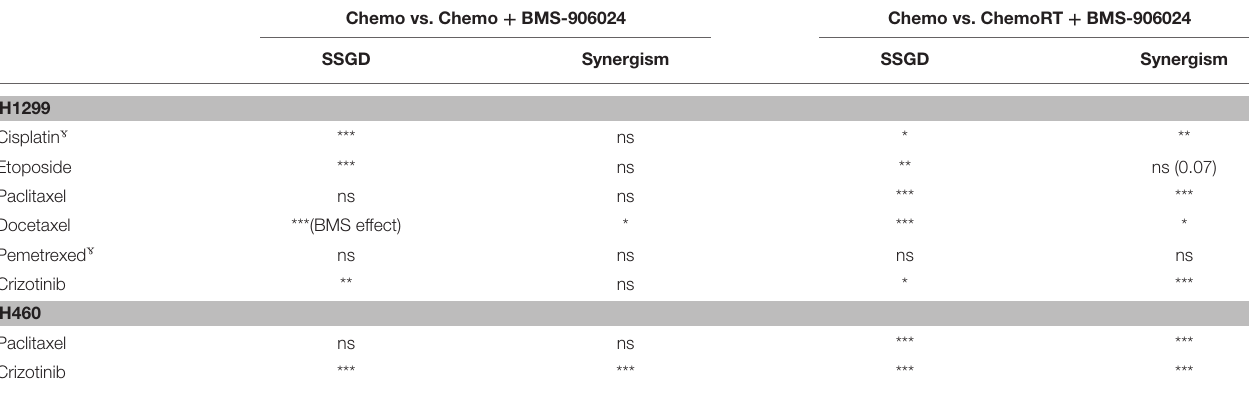
TABLE 1 | Synergistic interactions and statistical significance between combination treatments with and without BMS-906024 on SSGD.